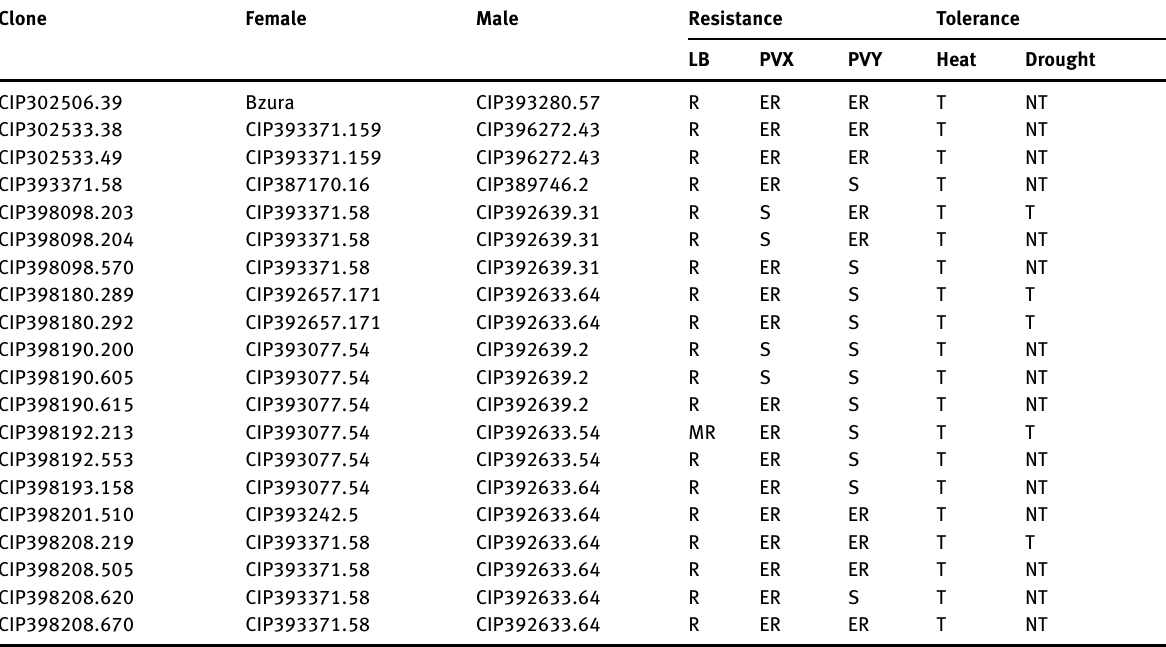
Table 4: Clones from LBHT, evaluated for glycoalkaloid content in San Ramon, La Molina and Majes in 2014-2015 Clone Female